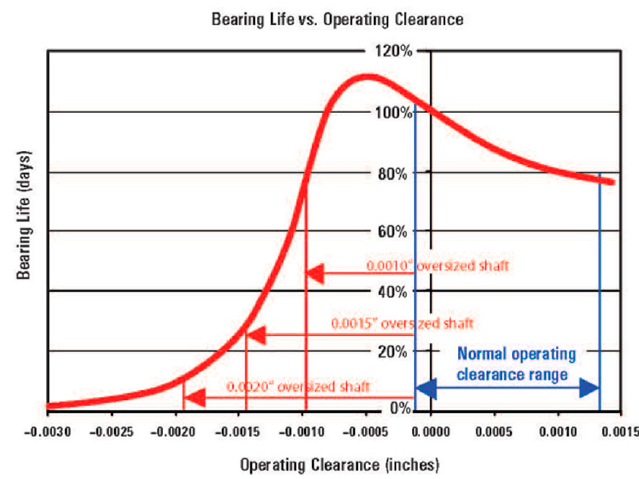
Figure 1. Dependence of the bearing life on the operating clearance [1].